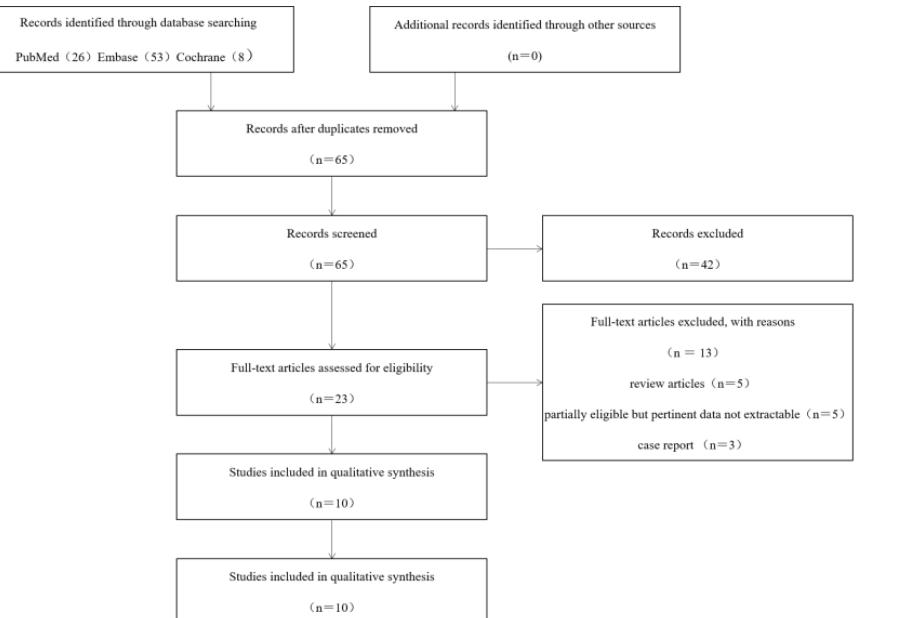
Figure 1. Flow diagram of the study selection process.